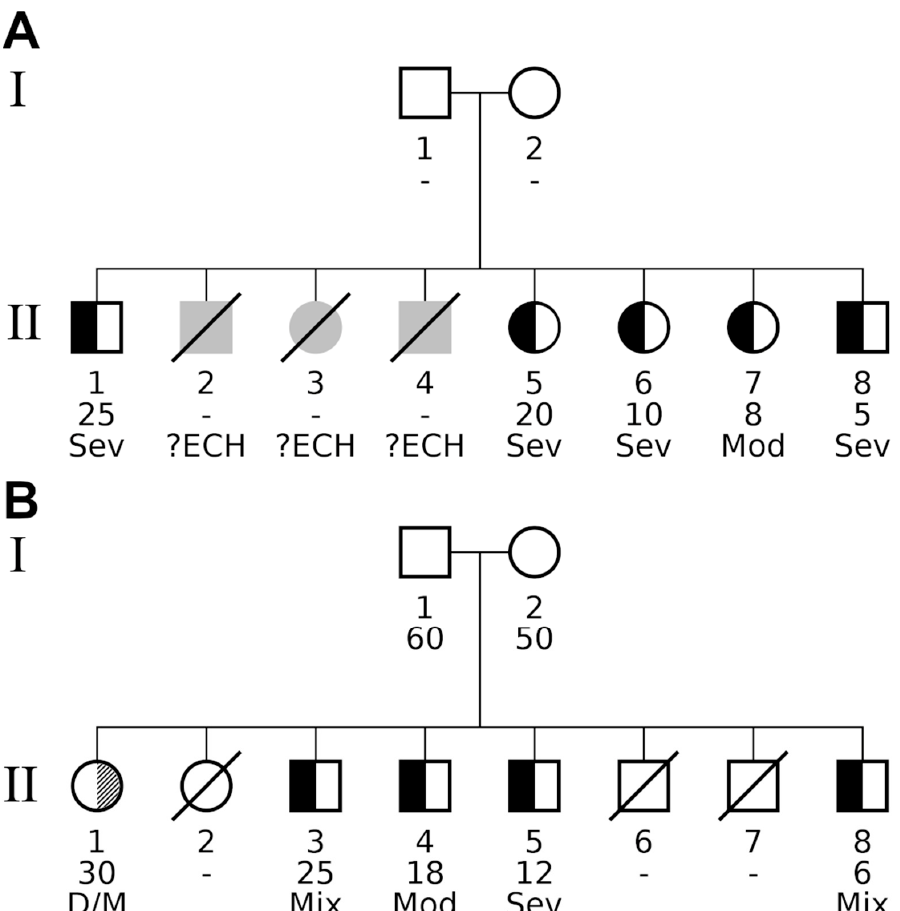
Figure 2. Pedigrees of nuclear families detected by various familial aggregation methods. The pedigrees contained two types of diseases, indicated by split family member symbols. Black fillings in the left half of a subject’s symbol indicate individuals a ff ected by the myxedematous phenotype. A diagonally hatched right-hand segment designates individuals exhibiting the neurological phenotype. Una ff ected individuals have a white (i.e., empty) segment encoding the respective phenotype. Additional information is given below a pedigree symbol. 1st line: participant identifier (unique for each generation); 2nd line: age at study participation, unknown age is specified by a hyphen (“-“). O ff spring are ordered from left to right by decreasing age; 3rd line: detailed description of the phenotype as follows: Sev (severe) or Mod (moderate) form of persistent myxedema; ?ECH, undefined phenotype of CH; D / M, deaf / mute; Mix, mixed form of myxedematous and neurological phenotype. Both families had healthy parents. ( A ) Significant myxedematous phenotype aggregation within family A. All living o ff spring showed signs of myxedema, and even diseased individuals II.2, II.3, and II.4 were reported by villagers to have had su ff ered from some form of endemic CH (indicated by grey symbols). The late subjects were born between individuals II.1 and II.5, and would have had an age between 20 and 25 years at the date of survey. Overall, family A consisted of eight a ff ected o ff spring, five alive and three deceased, all of them a ff ected by endemic CH. ( B ) Significant neurological and myxedematous aggregation in family B. In this family, individual II.1 exposed the neurological phenotype, so when investigating the combined phenotype for familial aggregation, family B had exactly the same number of a ff ected alive o ff spring and was reported with the same p -values by all three family-based tests. Looking at the myxedematous phenotype only revealed the major di ff erence compared with family A: four a ff ected individuals (II.3, II.4, II.5 and II.8) gave rise to a borderline significant result for tests Binom. Prob. and Kinship Sum ( p adj = 0.05 in both tests).